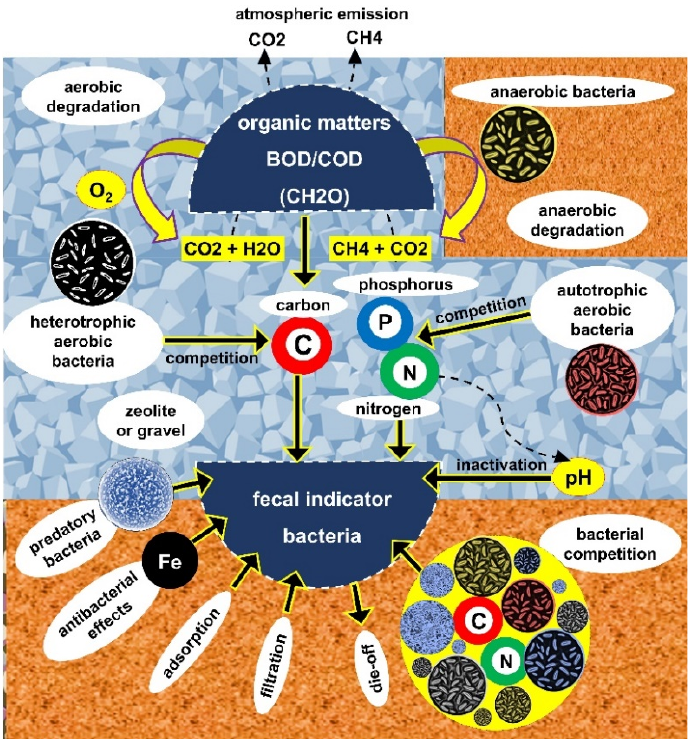
Figure 5. MSL layers design associated with the removal mechanisms of organic matter and fecal indicator